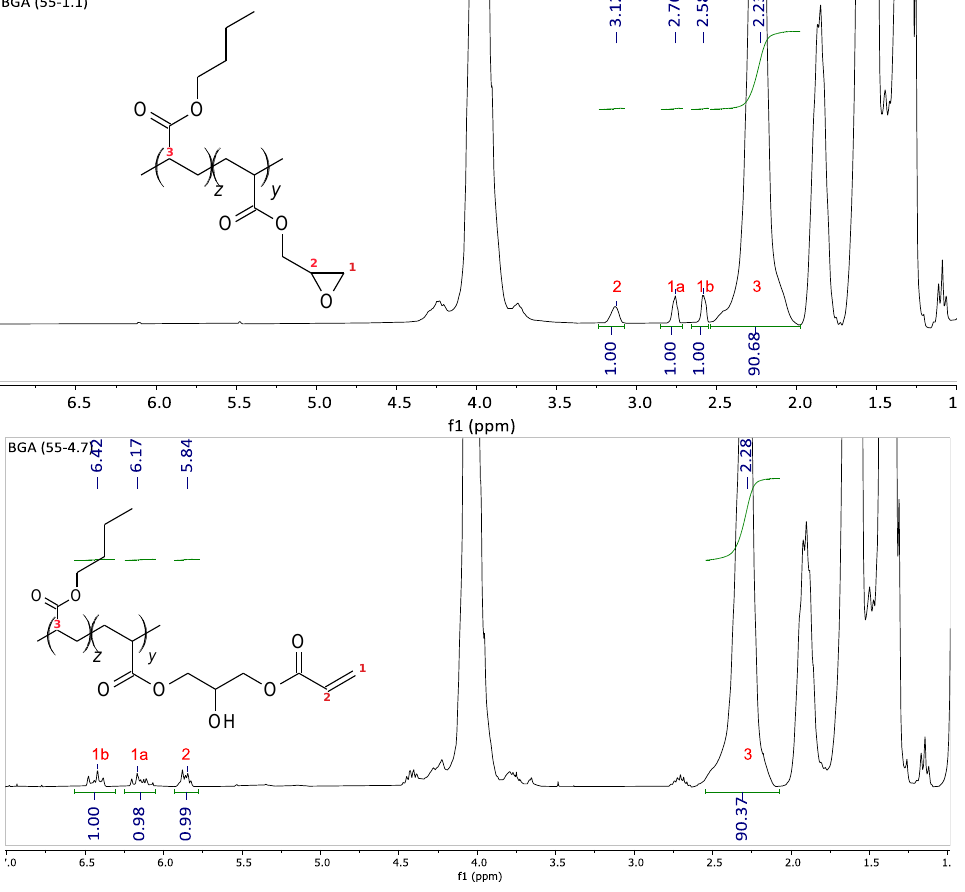
Figure 1. The 1 H NMR spectra of backbone B GA (55-1.1) before and after modification.